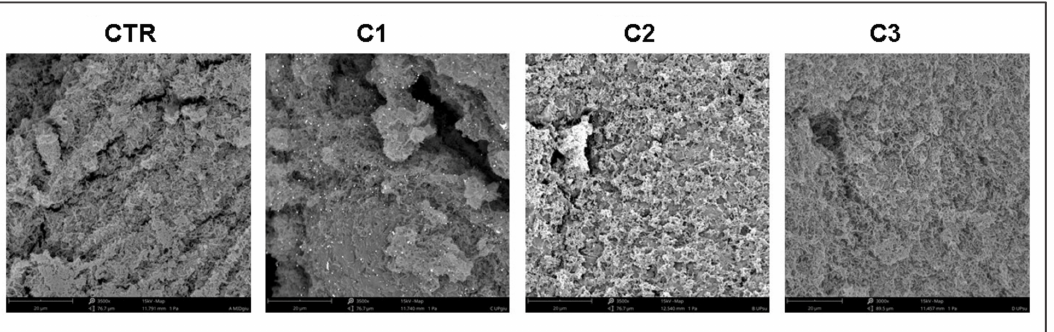
Figure 4. Representative SEM images of untreated (CTR) and treated LCWBs treated with C1, C2, and C3 combinations. For the experimental points, see Figure 1 and the Section 4, paragraph